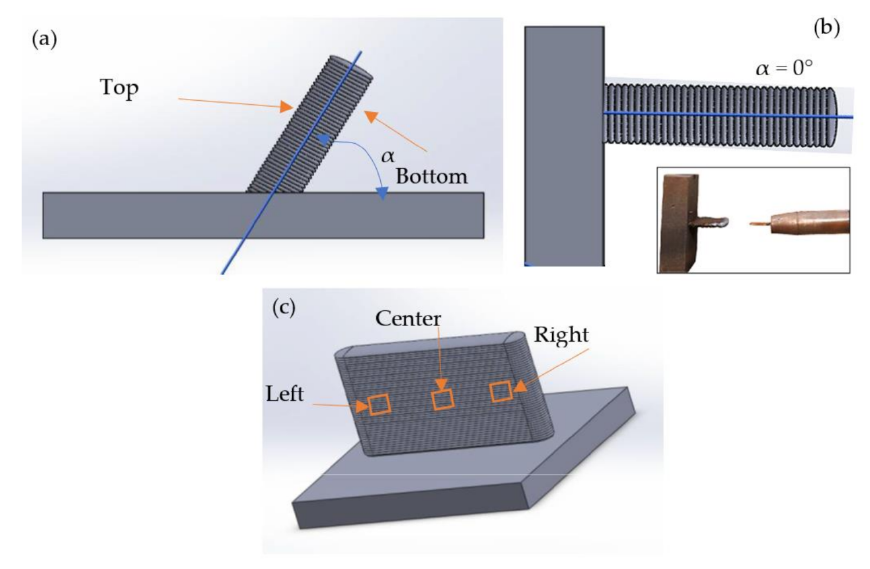
Figure 5. ( a ) Samples E ( α = 90 ◦ ) and samples F1, F2, and F3, ( b ) sample F4, ( c ) position of 3D surface measurements. Table 3. Parameters of 3D surface topography according to ISO